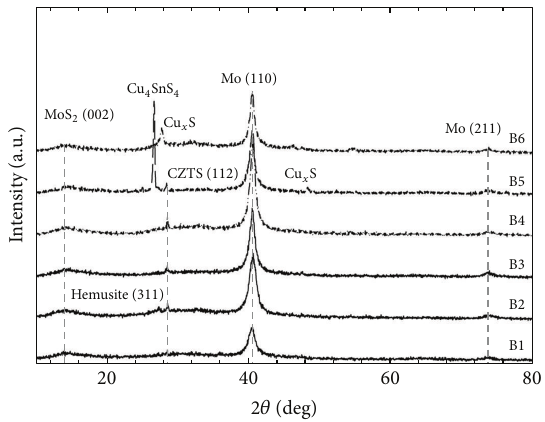
Figure 3: X-ray diffraction patterns of the annealed CZTS films grown at various substrate temperatures.